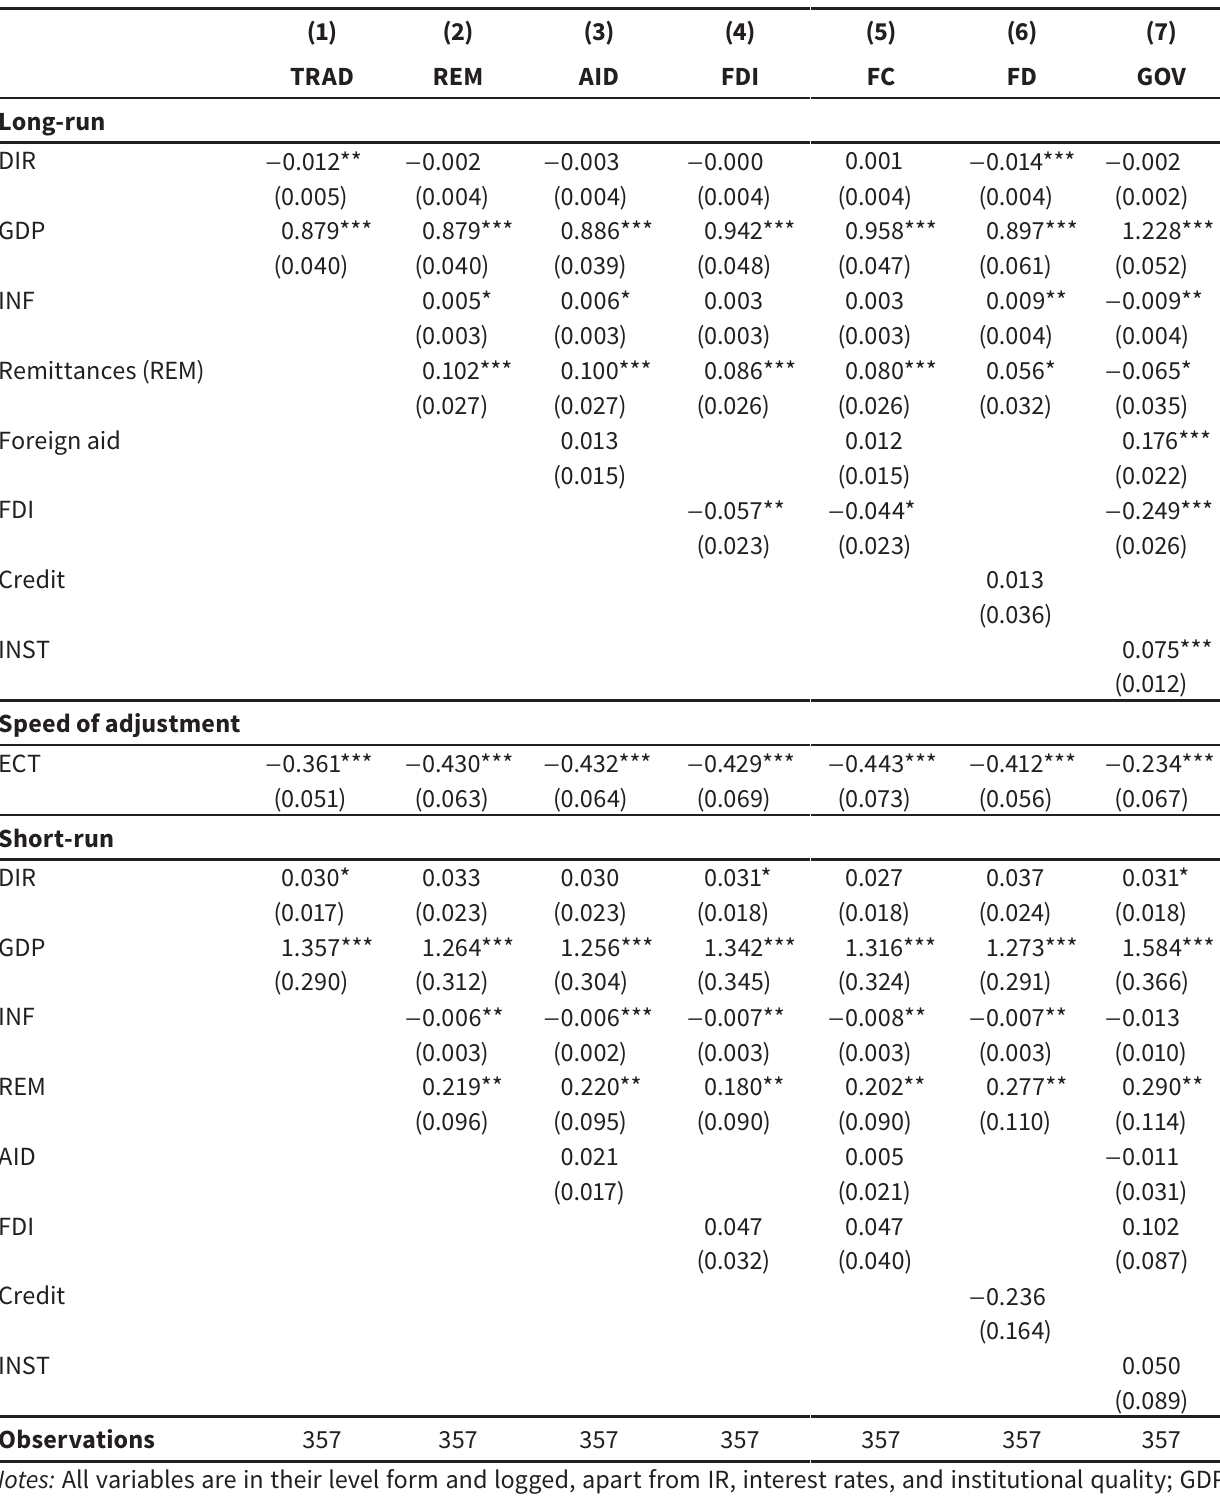
Remittances and